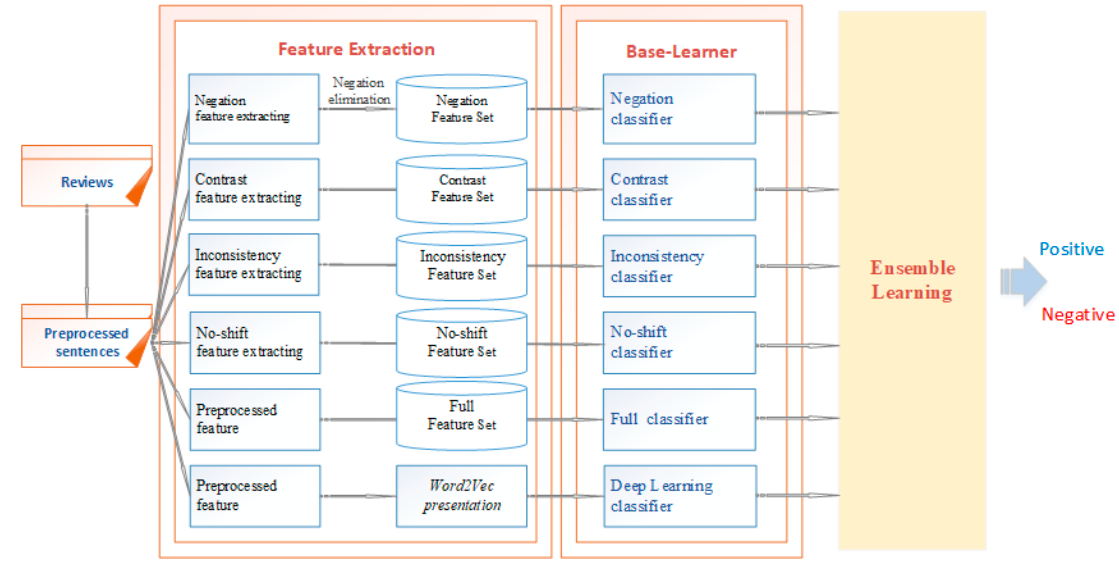
Figure 1. Architecture of sentiment classification system based on ensemble learning model.